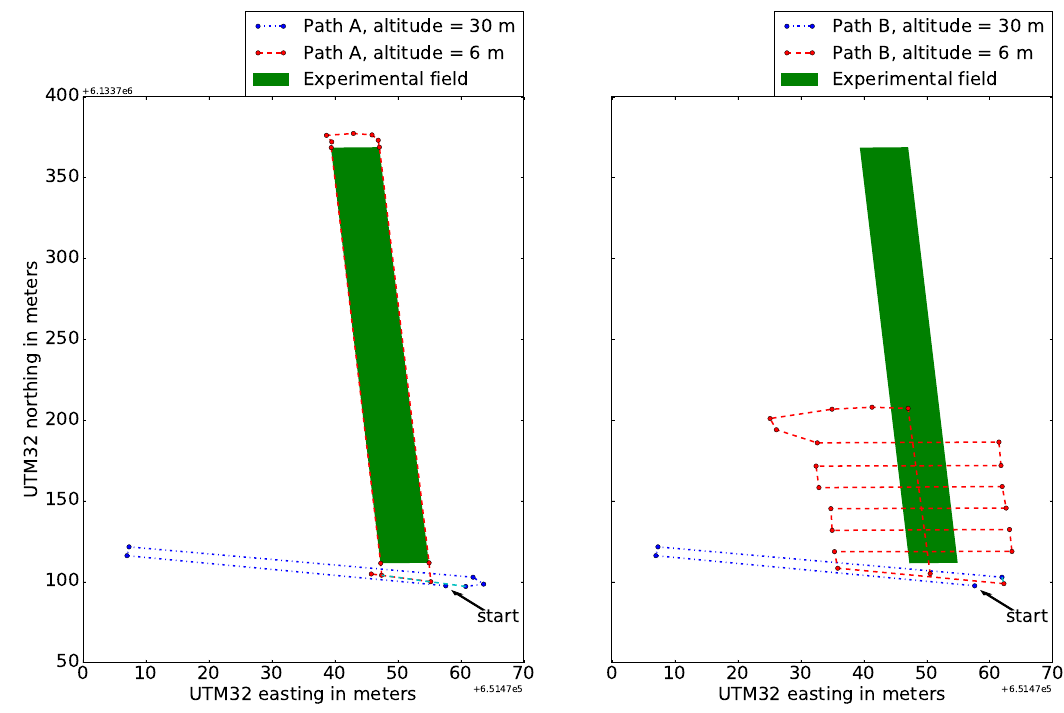
Figure 4. UAV flight Paths A and B over the experimental field. In Path A the UAV is set to move along the borders of the crop parcels. In Path B the UAV follows the crop rows